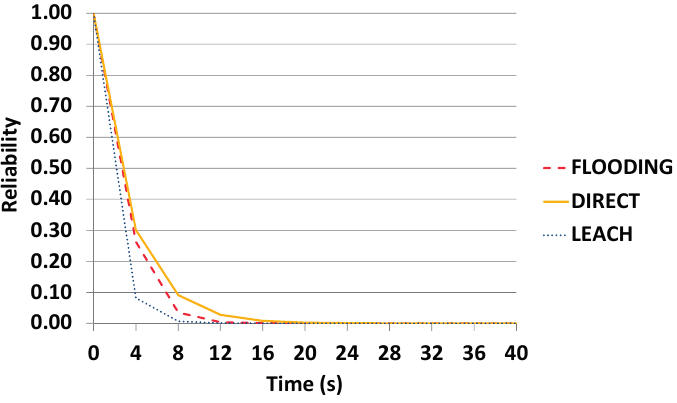
Figure 19. WSN reliability when the sensor has enough energy.